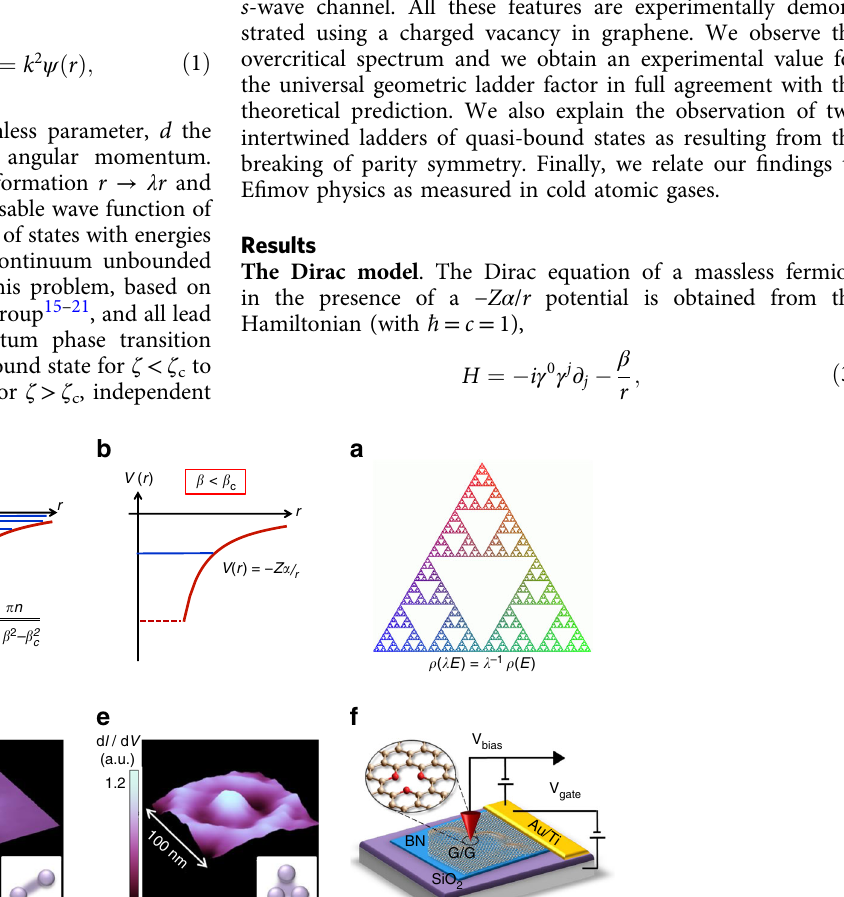
ffiffiffiffiffiffiffiffiffiffiffiffiffiffiffi q β 2 (cid:2) β 2 Þ . d , e Experimental d I /d V maps of charged c